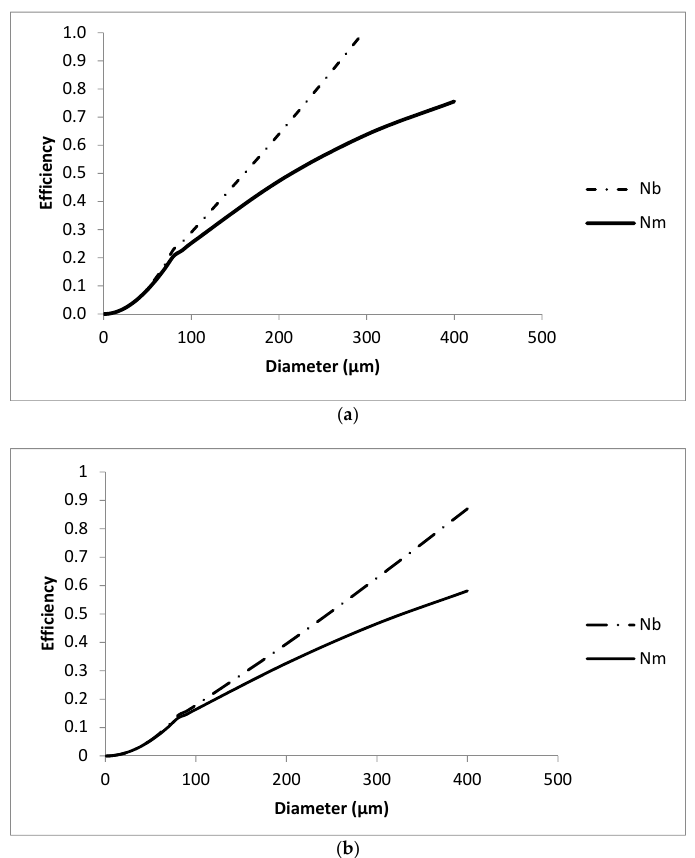
Figure 2. Efficiency-diameter relation for gravity settling in (a) MC720 (40,000 m 3 /h) and ( b ) MC820 (120,000 m 3